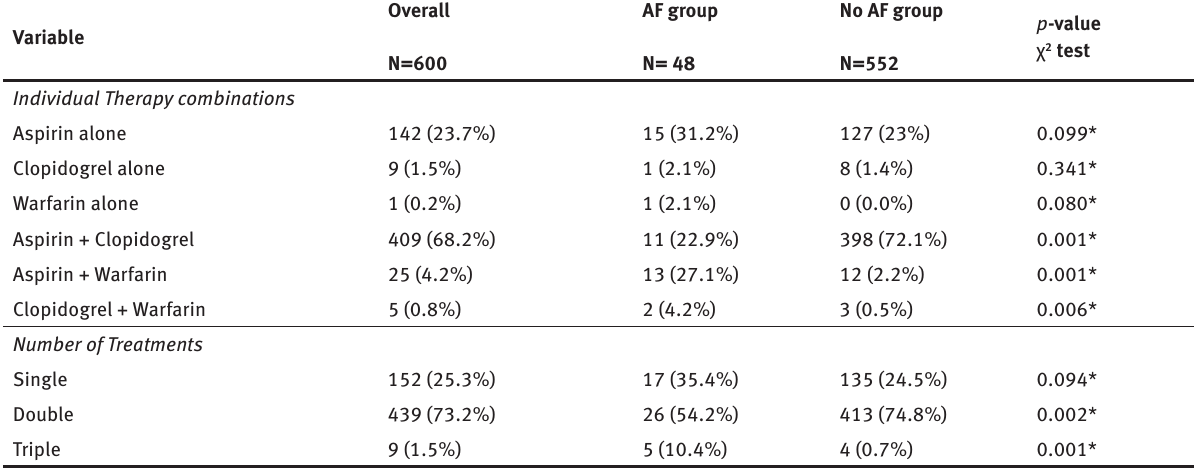
Table 3: Antithrombotic treatment strategy after hospital discharge in patients with acute myocardial infarction in regards to presence or absence of atrial fibrillation. Variable